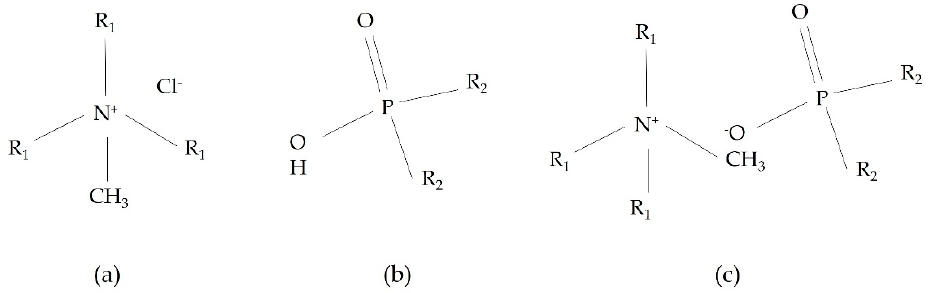
Figure 1. Molecular structure of the reagents and IL used in this work ( a ) Aliquat 336 ( b ) Cyanex 272, and ( c ) R 4 NCl.